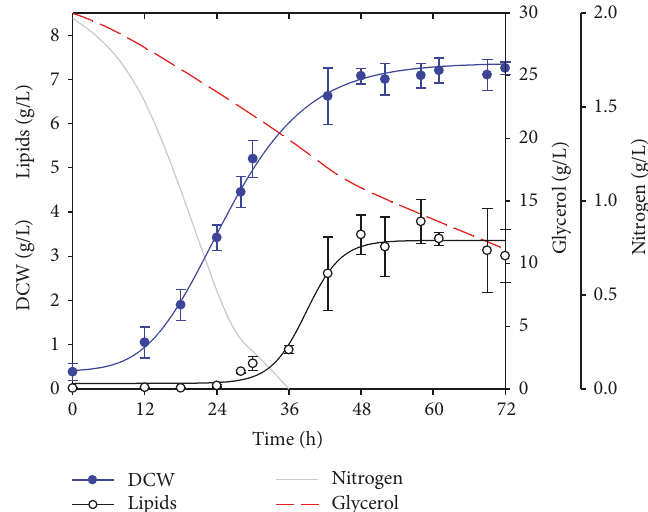
Figure 1: Y. lipolytica flask culture kinetics.